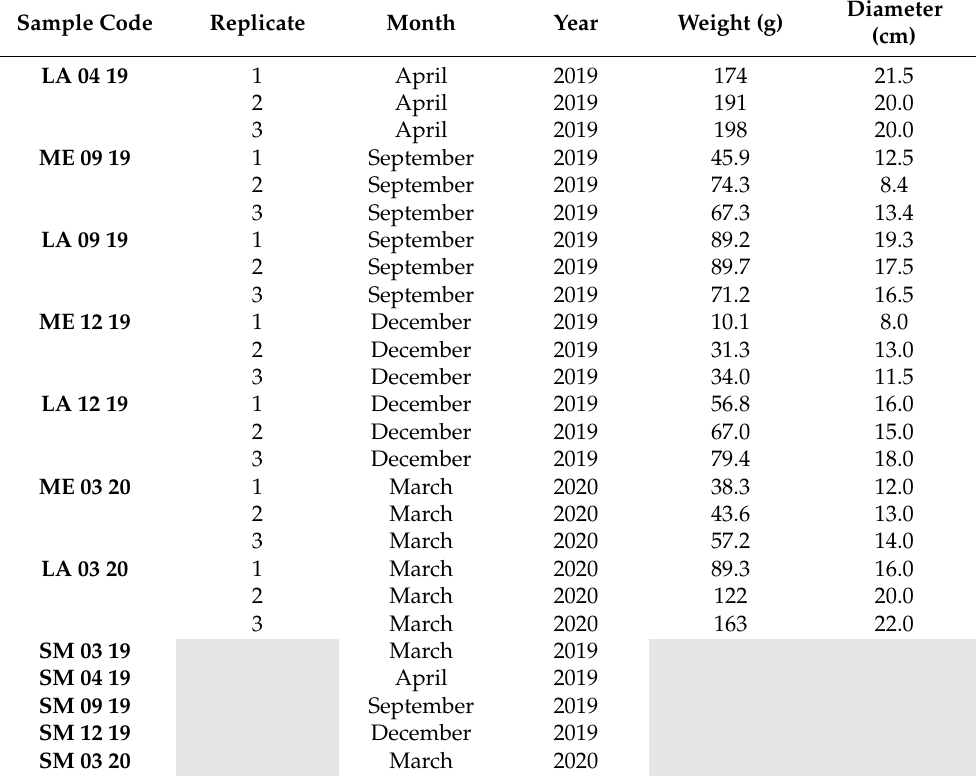
Table 1. Sample codes for starfish and starfish meal (SM). Starfish sampling (n = 3) month, year, weight, and size (ME: medium; LA: